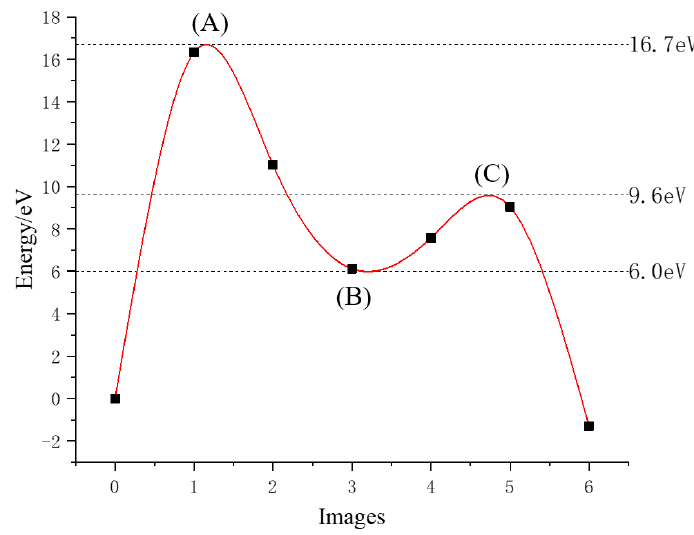
Figure 9. Minimum energy path for oxygen atom diffusion.